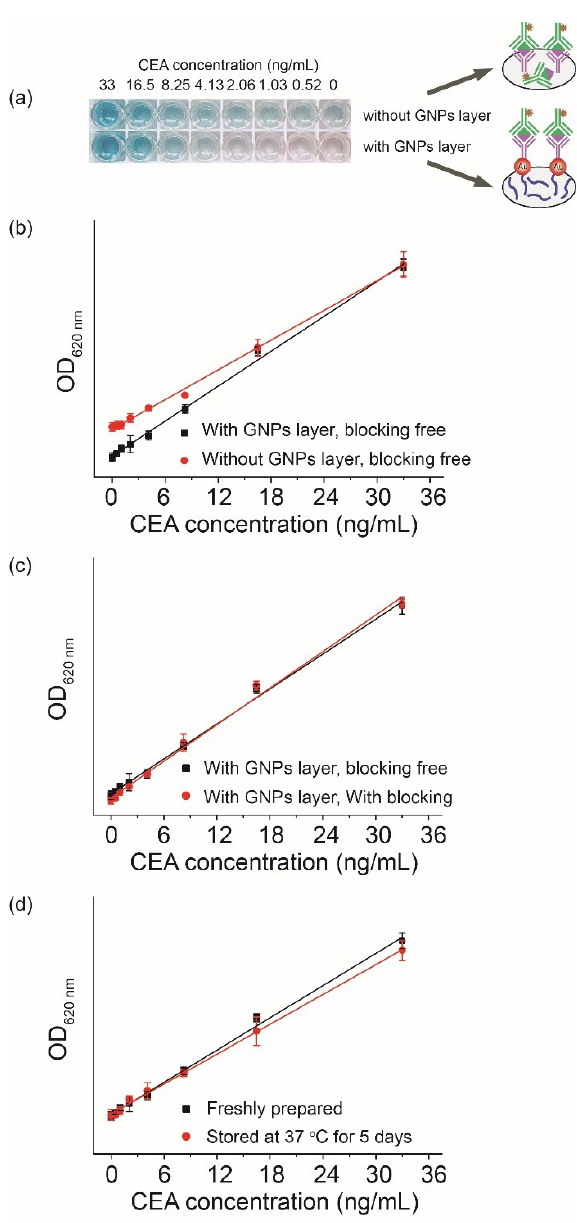
Figure 3. The results of the blocking-free ELISA. Pictures of the blocking-free ELISA on the microplate without and with the GNP layer ( a ); OD 620 vs. CEA concentration of the blocking-free ELISA on the microplate without and with the GNP layer ( b ); OD 620 vs. CEA concentration of the routine and blocking-free ELISA on the microplate with the GNP layer ( c ); OD 620 vs. CEA concentration of the blocking-free ELISA on microplates with the GNP layer prepared freshly and stored at 37 °C over a period of five days ( d ).